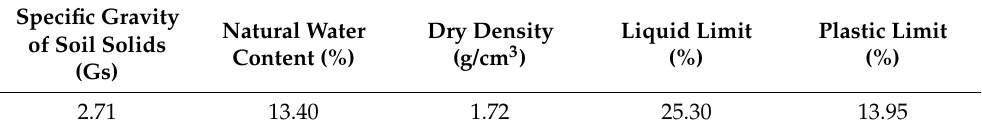
Table 2. Basic physical and mechanical properties of